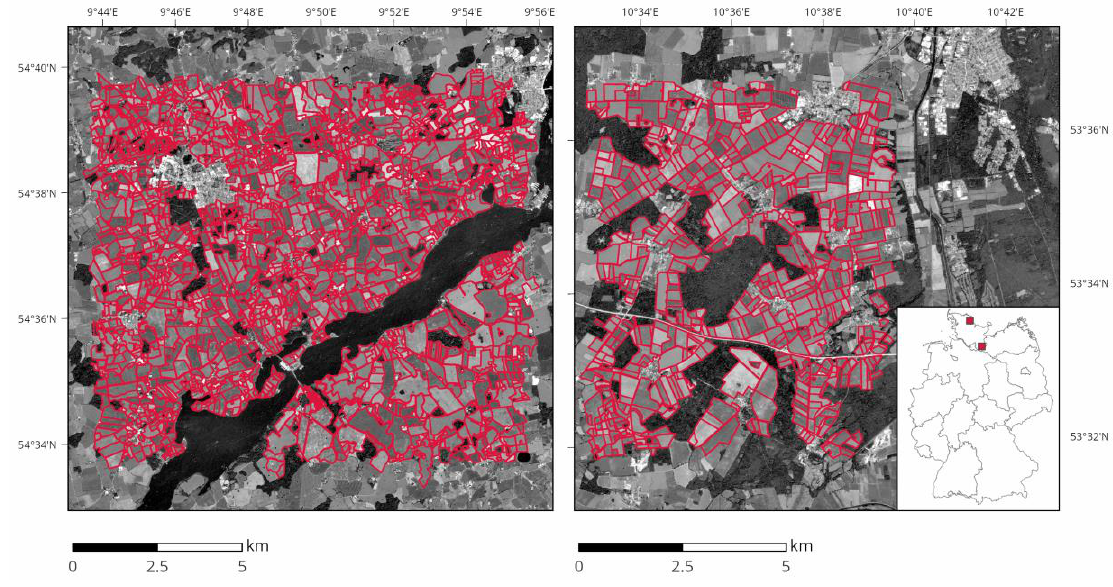
Figure 1. Maps of study areas 1 ( left ) and 2 ( right ).